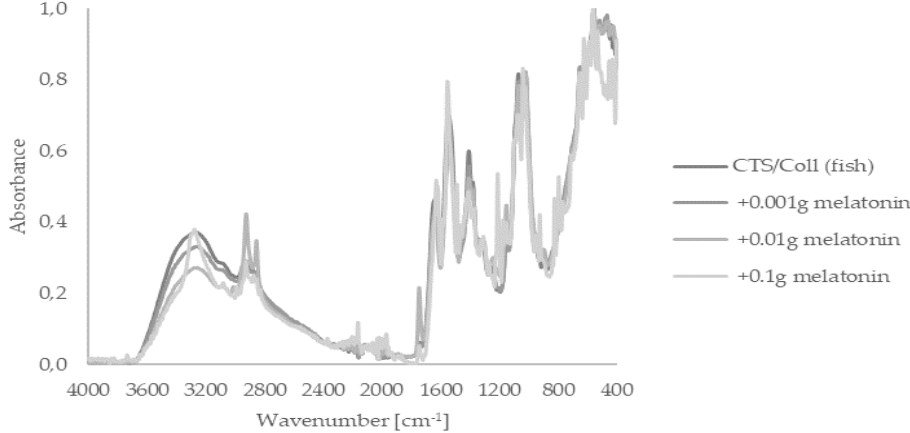
Figure 1. The FTIR-ATR spectra of scaffolds based on chitosan (CTS)/collagen (Coll) (derived from Salmo salar fish skin) mixture with and without melatonin in a dose-dependent manner.